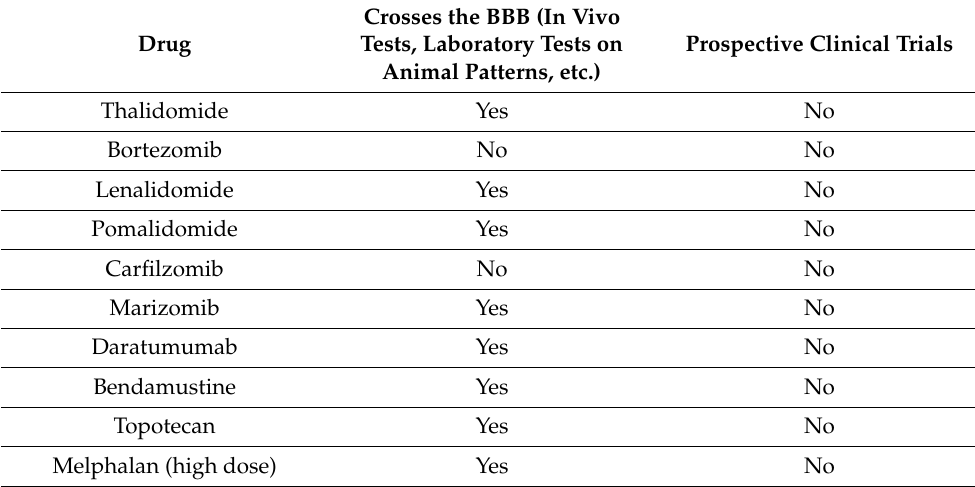
Table 1. Agents used for multiple myeloma treatment and their potential to cross the BBB. Crosses the BBB (In Vivo Drug Tests, Laboratory Tests on Animal Patterns,